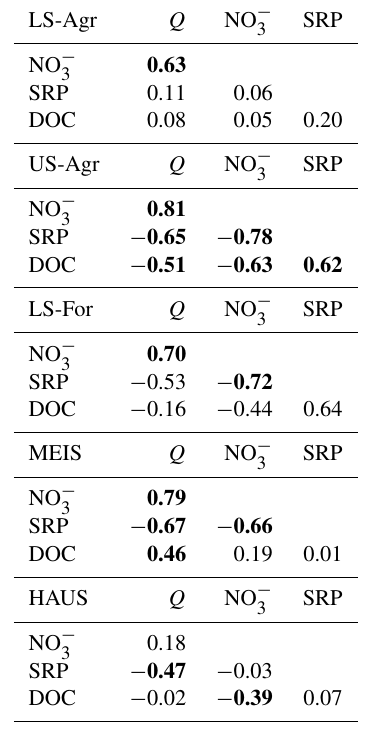
Table 3. Spearman’s rank correlations for discharge (Q) and con- centration parameters. Significant correlations ( p < 0 . 05, Holm- corrected) are in